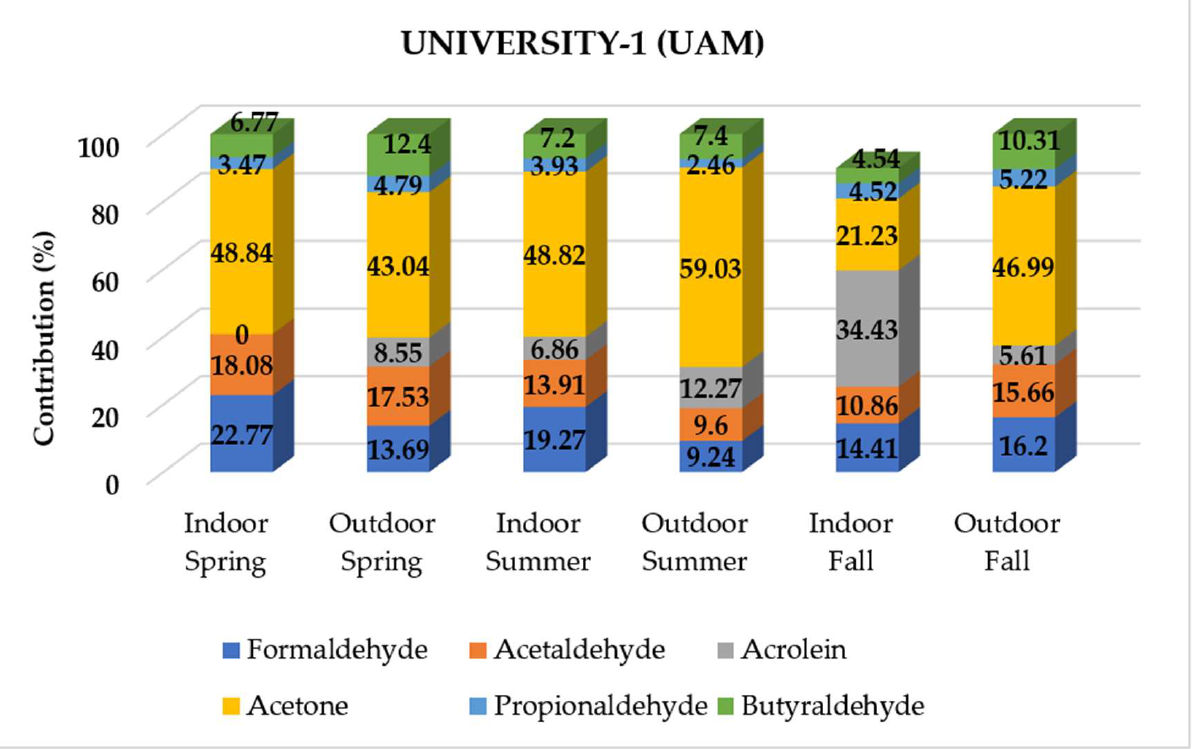
Figure 3. Seasonal variation of the contribution percentage of each carbonyl compound to the total carbonyl concentrations (indoor and outdoor) in University-2 (UDLA).